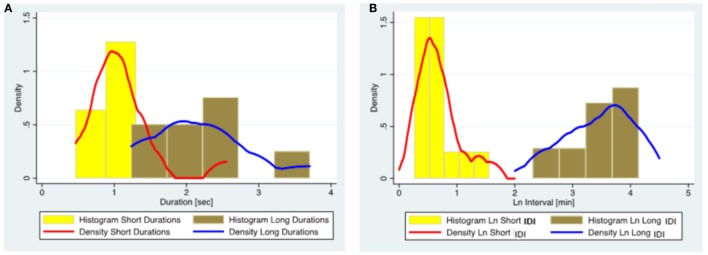
The distribution of ED duration and IDI based on the data from 15 subjects diagnosed with juvenile absence epilepsy. (A) Histograms and kernel density plots of ED duration predictions jointly for the short and long duration populations detected by the finite mixture modeling. (B) Histograms and kernel density plots of the Ln of the IDI predictions jointly for short and long populations detected by the finite mixture modeling. (Please note that IDIs were logarithmically transformed in the histogram as the original data were skewed.) ED, epileptiform discharge; IDI, interdischarge interval; Ln, Log (natural).